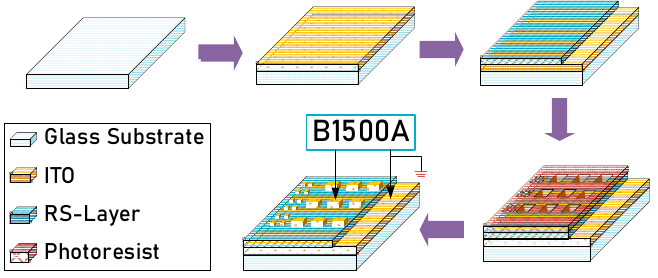
Figure 1. Schematic diagram of devices fabrication process.